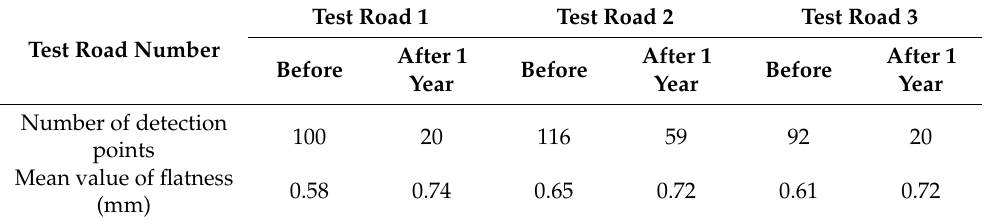
Table 6. Flatness test results of the test roads before and after the operation.